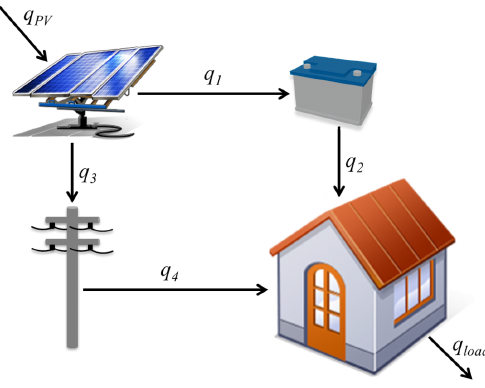
Figure 9. Schematic for the power flow example with photovoltaic panel, battery, electric grid, and a load (represented by the building) with the corresponding flows defined between these